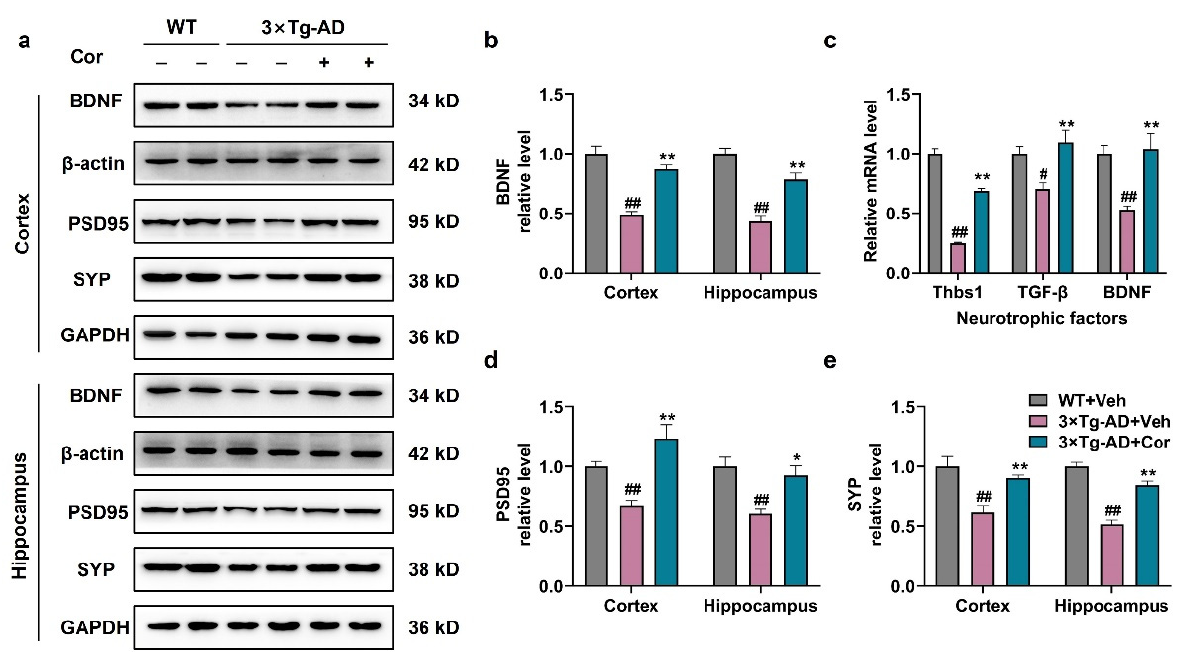
Figure 6. Cornuside increased neurotrophic factors levels and repaired synaptic function in 3 × Tg-AD mice. ( a ) Typical micrographs and ( b , d , e ) quantitative assessments of hippocampal and cortical BDNF, SYP, and PSD95 proteins for the 3 × Tg-AD mice with or without cornuside therapy versus the WT mice ( n = 6 per group). ( c ) The mRNA expression of neurotrophic factors including Thbs1, TGF- β , and BDNF were detected in 3 × Tg-AD mice with or without cornuside administration in contrast to the WT controls ( n = 5 per group). Data are all denoted as mean ± SEM. # p < 0.05 and ## p < 0.01 compared with WT + Veh; * p < 0.05 and ** p < 0.01 compared with 3 × Tg-AD + Veh group.